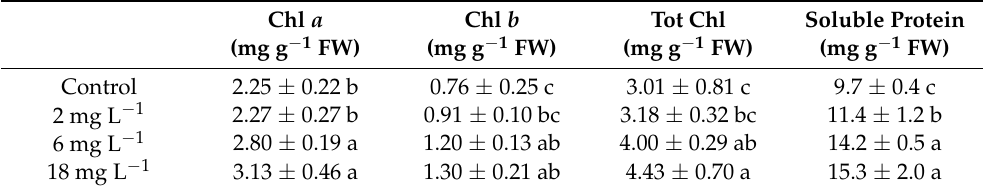
Table 1. Chlorophyll a (Chl a ), chlorophyll b (Chl b ), total chlorophyll (Tot Chl), and soluble protein found in olive proliferated explants.